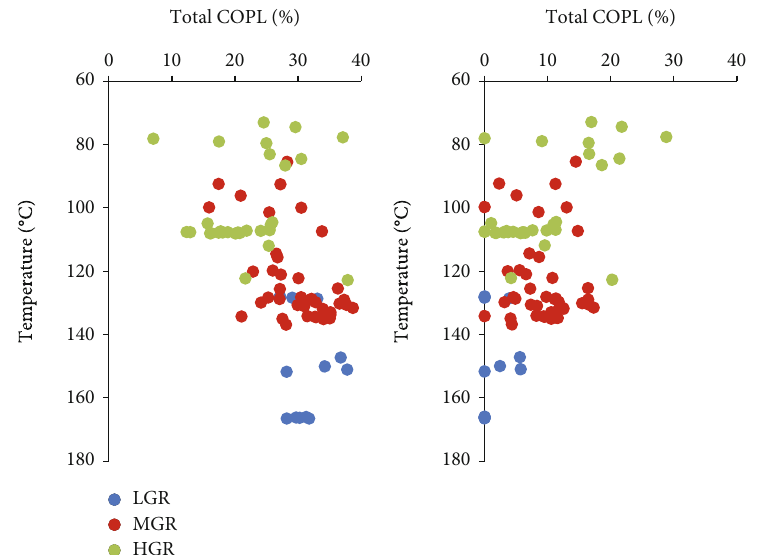
Figure 12: The total COPL and T-COPL vary with the present formation temperature in di ff erent geothermal gradient